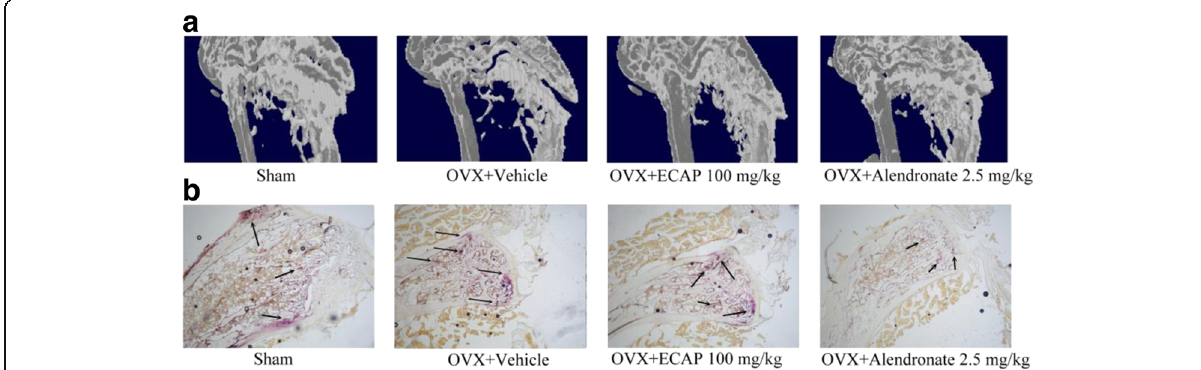
Fig. 5 ECAP inhibits osteoporosis in OVX mice. a The distal left femoral metaphysis was scanned using a micro-CT after 4 weeks in OVX mice. b The left femora were fixed, decalcified, embedded, and sectioned. Sections were stained with TRAP after 4 weeks in OVX mice